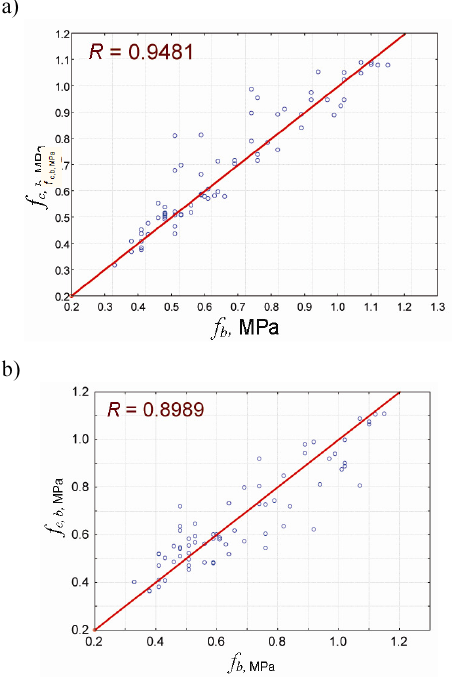
Fig. 12. Correlation between pull-off adhesion f b experimentally determined by seminondestructive pull-off method and pull-off adhesion f c.b identified by network C in verification Figure 12 presents the correlation between experimentally determined pull-off adhesion f a,b